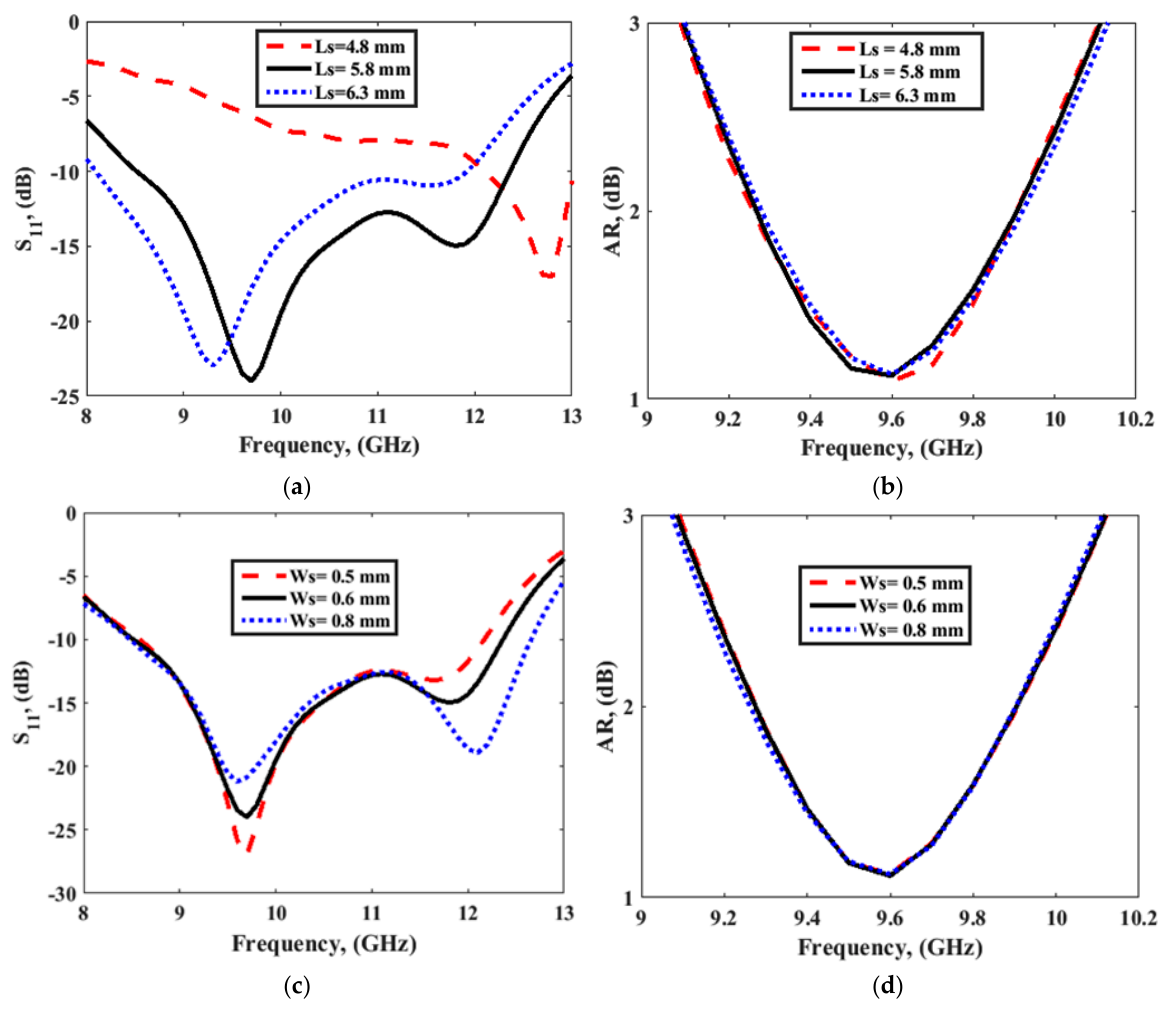
Figure 3. Effect of parameters L s on ( a ) S 11 and ( b ) AR and the effect of w s on ( c ) S 11 and ( d ) AR, for single-element